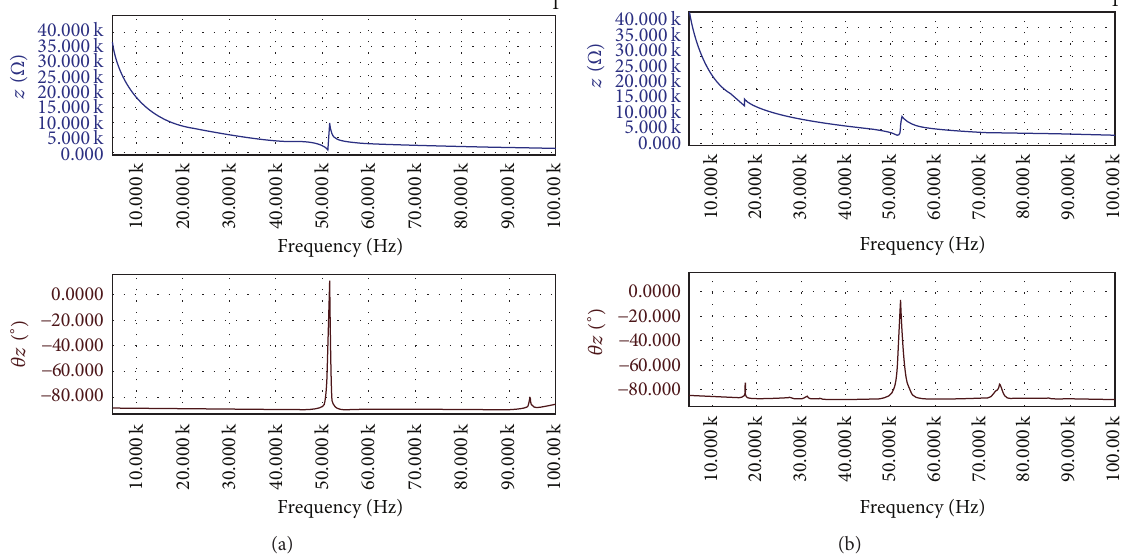
Figure 10: Measured impedance and phase of the symmetrical (a) and asymmetric (b) ring type actuator versus